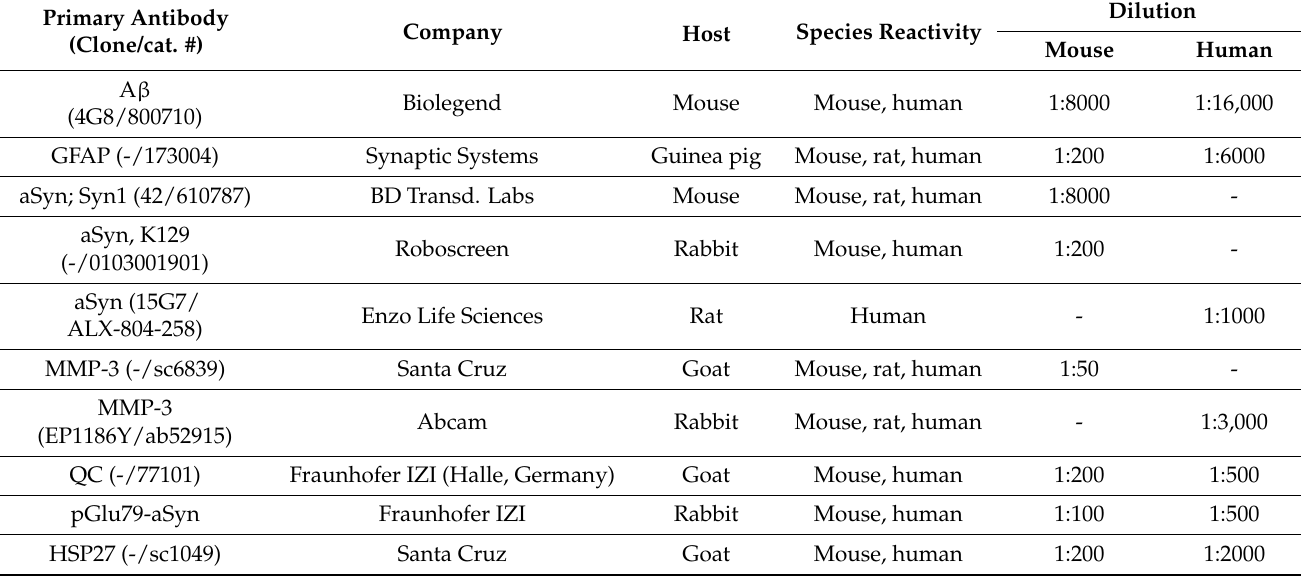
Table 1. Primary antibodies used for single labeling